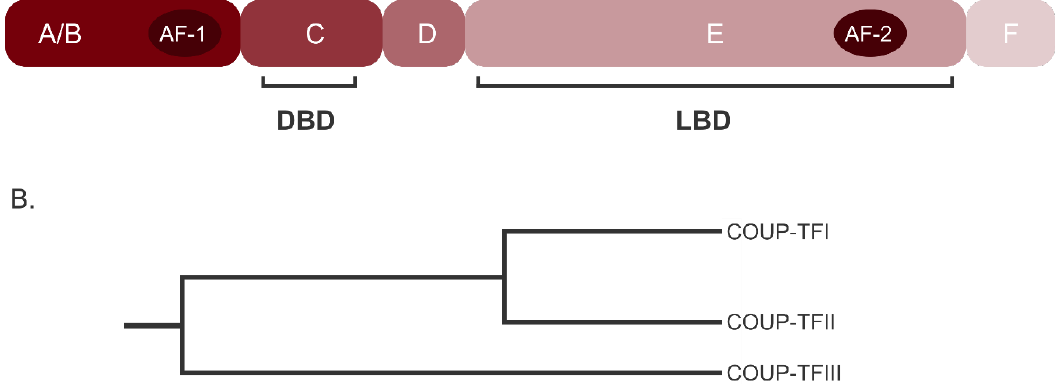
Figure 1. COUP-TFII protein and family relation. ( A ) The main isoforms of COUP-TF proteins possess the typical features of the NR domain structure of COUP-TFs nuclear receptor (NR). ( B ) Phylogram (guide tree) with cladogram branch length of the NR2F family showing that separation of COUP-TFIII from COUP-TFII and COUP-TFI is probably an early evolutionary event (data obtained from ClustalOmega alignment of human NR2F1, NR2F2 and NR2F6). Based on References [1–3].